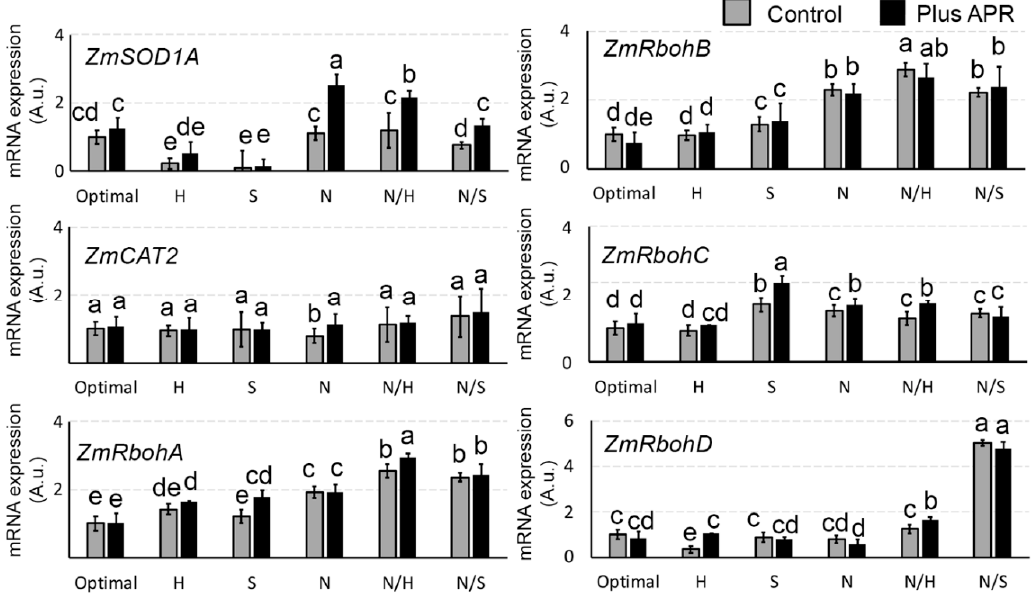
Figure 7. The expression patterns of ROS-related genes in response to different single and combined abiotic stress are influenced by the presence of APR ®. Q-PCR analyses were carried out on root of stressed (H, S, N, N/H, N/S) or unstressed (optimal) maize seedlings grown for 3 days in absence (grey bars) or in presence (black bars) of 5% APR®. Relative mRNA level represents data normalized to control (Optimal = 1). The values shown are means of three biological replicates ± SE. Significantly different values ( p < 0.05) are evidenced by different letters (One-way Anova, LSD post-hoc test).